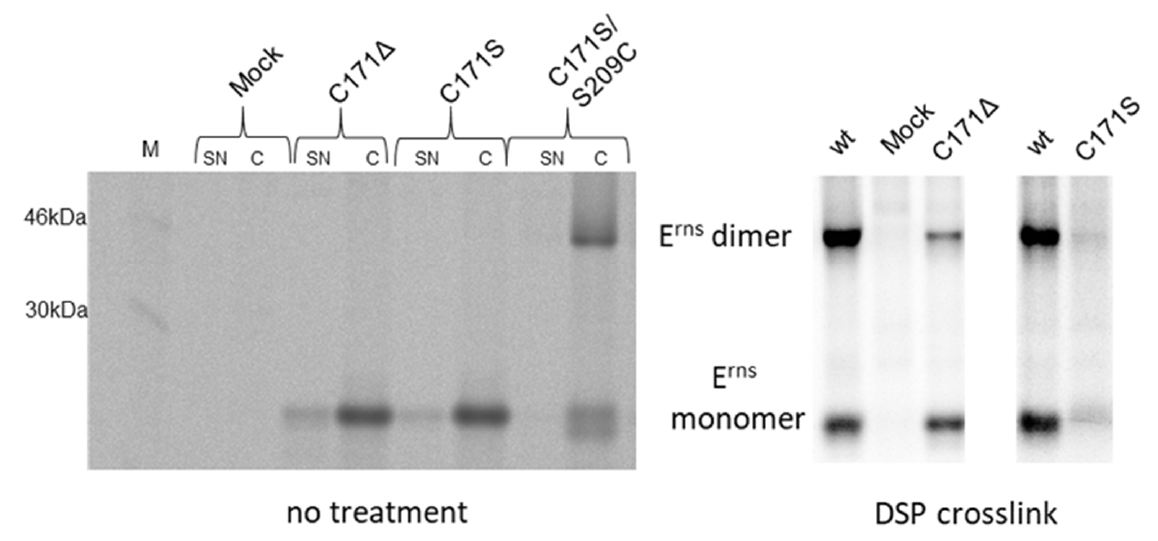
Figure 1. Monomers of E rns lacking C171 form dimers when subjected to DSP crosslink. Results of immunoprecipitation experiments of proteins transiently expressed from constructs coding for E rns wt or mutants with the indicated alterations. Proteins were radioactively labelled in situ and either left untreated ( left part) or subjected to DSP crosslink prior to cell lysis ( right part). Precipitation was done with E rns -specific monoclonal antibody 24/16 [37]. Precipitates were treated with PNGase F prior to separation by 10% SDS-PAGE under nonreducing conditions. M: bands of a size marker. Mock cells were infected with MVA-T7 and incubated with radioactive amino acids but not transfected with a plasmid. For the experiment shown on the left, both cell extract (C) and cell culture supernatant (SN) were analyzed. Since the supernatant did not contribute to the subject of the experiment, we omitted SN analysis when conducting the crosslink experiment. As obvious, the right part represents lanes from two different gels. Therefore, the wt control is shown twice here.